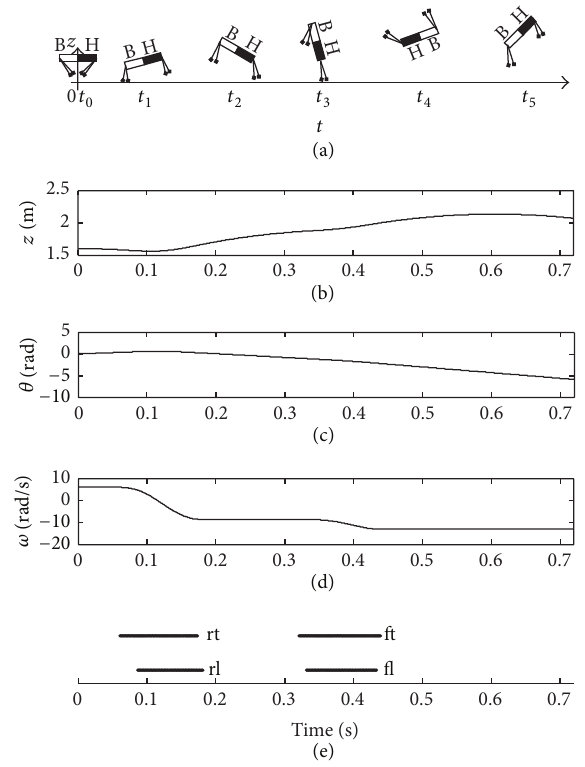
Figure 11: Imbalance posture of the quadruped robot without control.